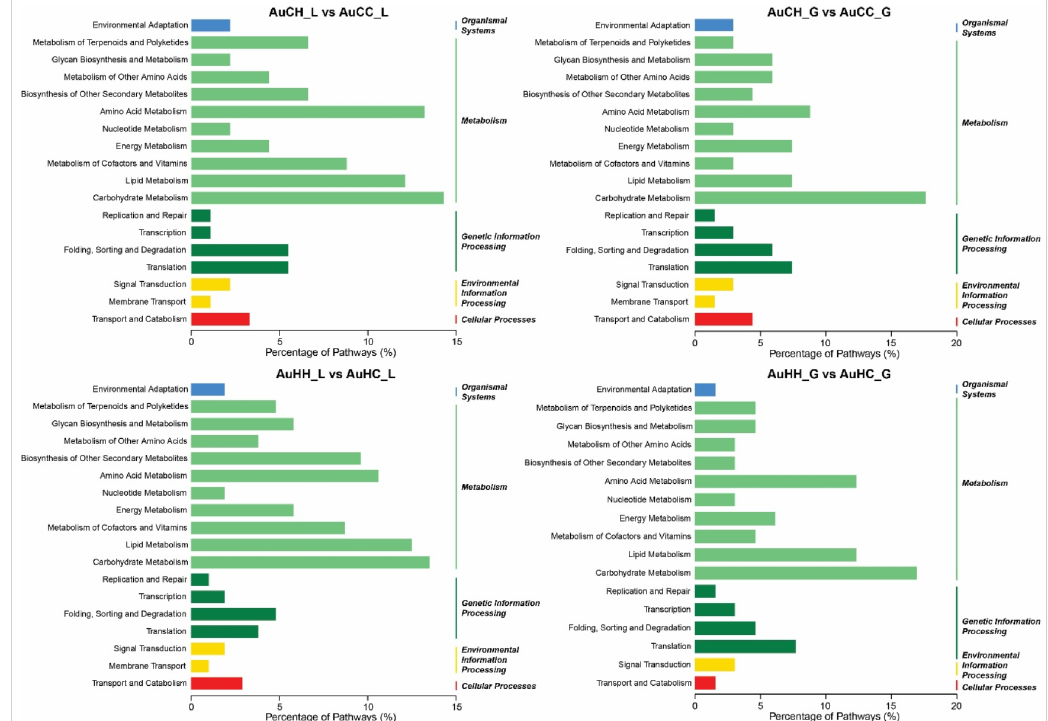
Figure 5. KEGG pathway classification of progeny heat stress-responsive miRNA-mRNA regulatory modules in different pair-wise comparisons. The treatment groups are: AuCC (DBA Aurora progeny treated with the control, originated from control group parents), AuCH (DBA Aurora progeny treated with heat stress, originated from control group parents), AuHC (DBA Aurora progeny treated with the control, originated from heat stress group parents), AuHH (DBA Aurora progeny treated with heat stress, originated from heat stress group parents). _L indicates flag leaf library and _G indicates developing grains